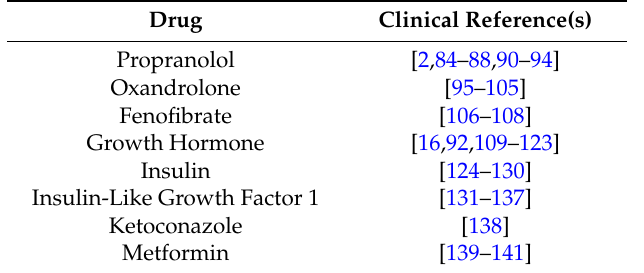
Table 1. Recent pharmacotherapeutic agents used in the treatment of burn